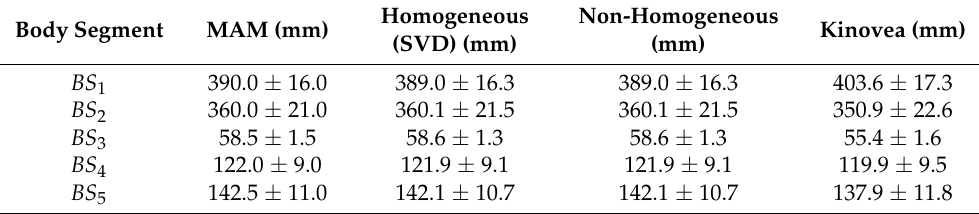
Table 5. Results of the anthropometric measurements of length of the BSs (n = 12). Body Segment